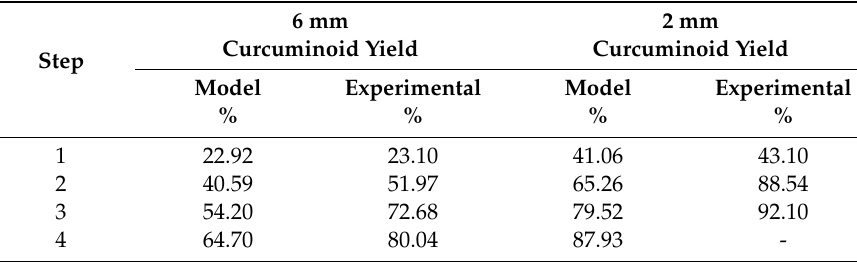
Table 6. Model fitting to cross-flow screening.